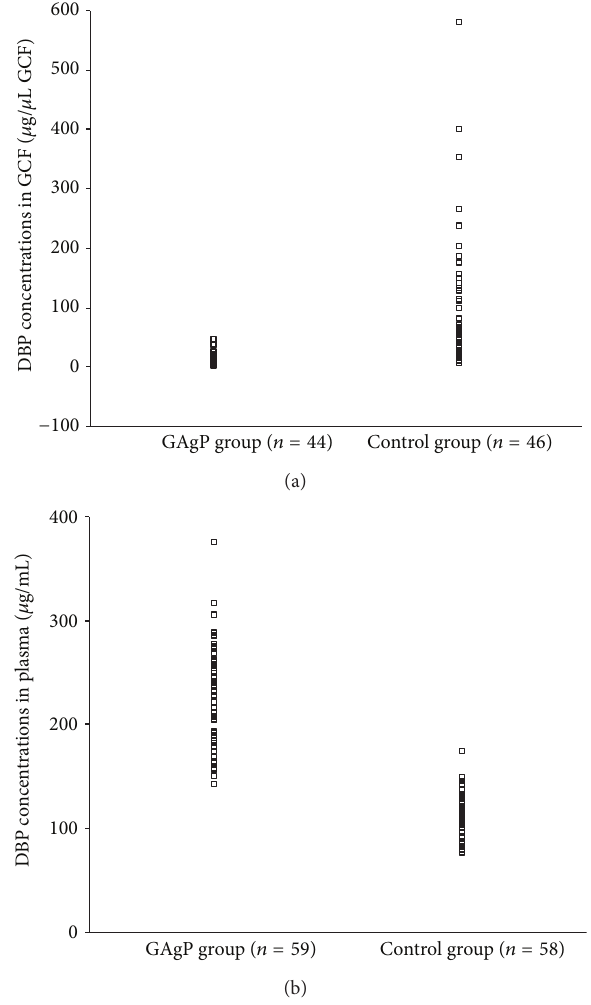
Figure 1: (a) DBP concentrations in GCF of GAgP group were significantly lower than in control group ( 𝑃 < 0.001 ); (b) DBP concentrations in plasma of GAgP group were significantly higher than in control group ( 𝑃 < 0.001 ).